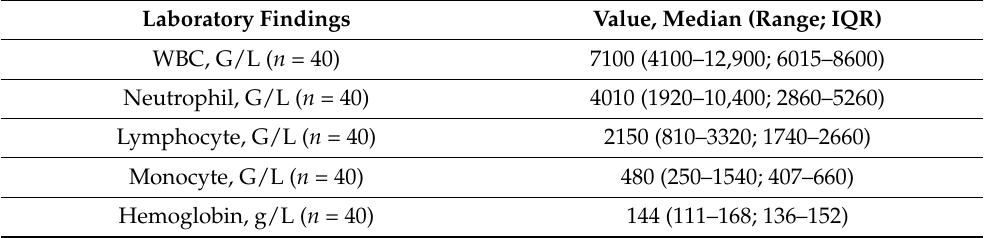
Table 2. Laboratory findings of an adolescent with chest pain and suspected myocarditis related to COVID-19